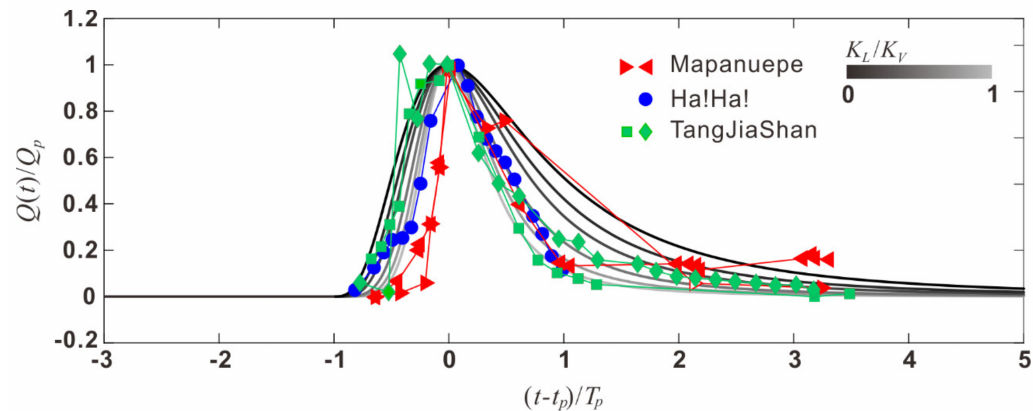
Figure 12. Dimensionless discharge hydrographs of the field-observation cases (the lines with symbols) and model-predicted hydrographs with different coefficient ratio of K L / K V (grayscale